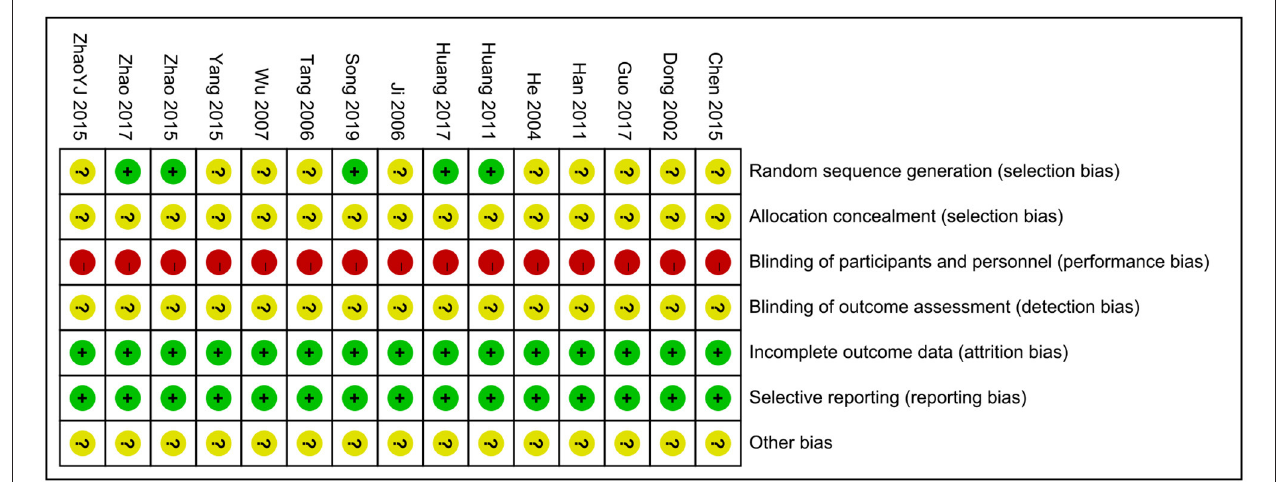
FIGURE 2 | Risk of bias